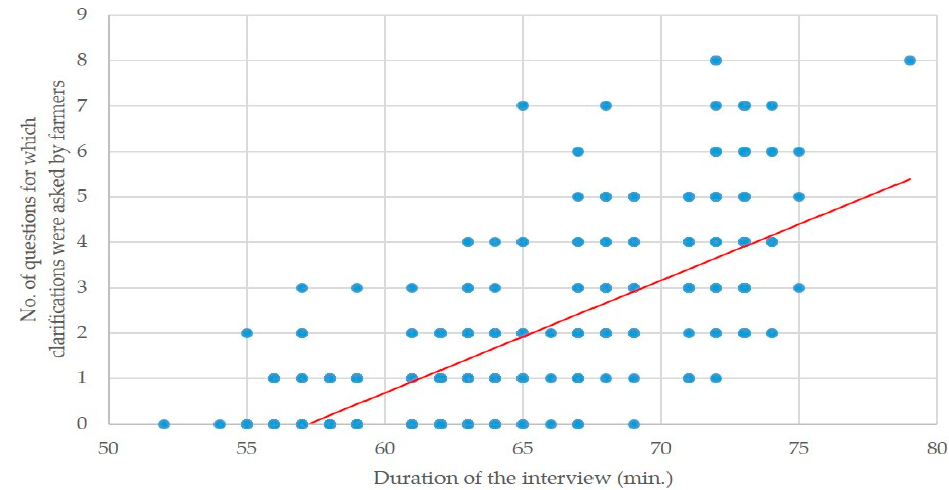
Figure 3. Plot diagram of the duration of the interview versus the number of clarifications asked by the farmers (solid red line indicates tendency line).